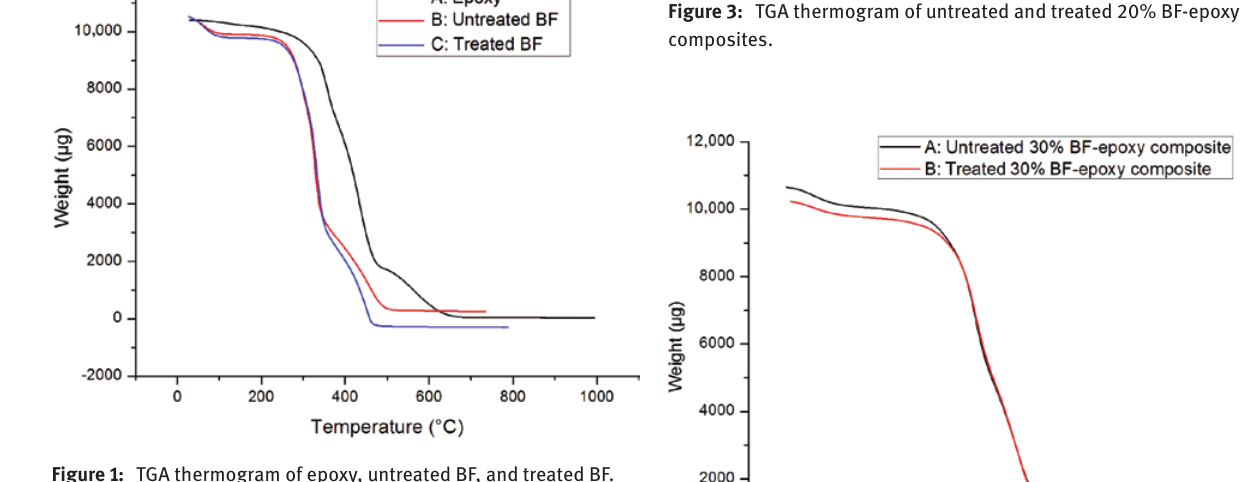
Figure 1: TGA thermogram of epoxy, untreated BF, and treated BF.